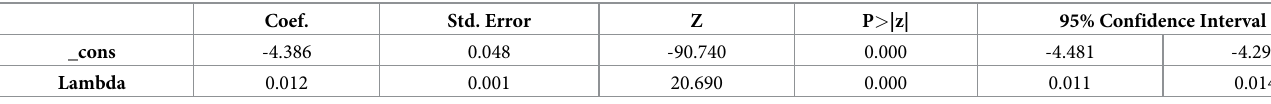
Table 6. The Exponential classical estimated parameters.